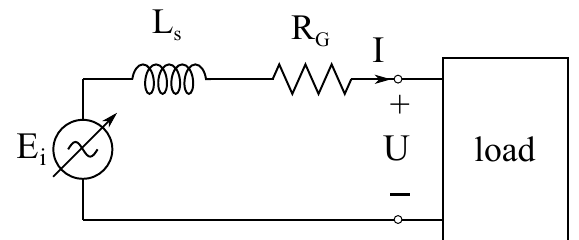
Figure 2. One-phase circuit model of the generator, connected to an external load. Here, a non-salient generator is